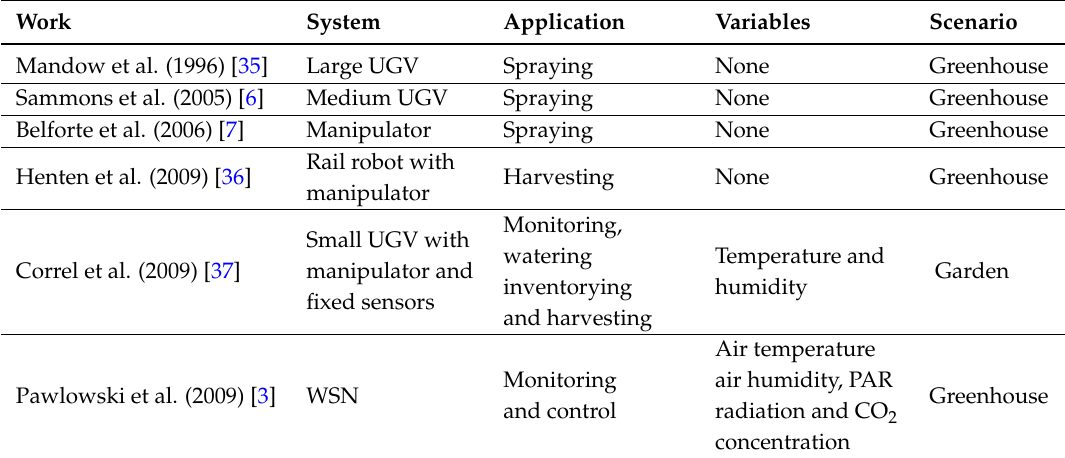
Table 1. Complete relevant state of the art of the